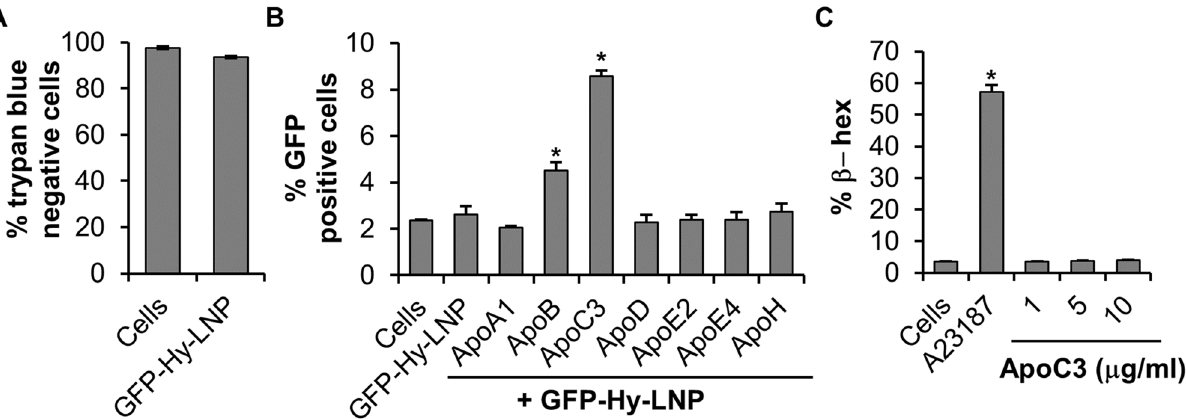
Figure 3. ApoC3 facilitates internalization of GFP-Hybrid-LNP (GFP-Hy-LNP) into BMMC. ( A ) BMMC were treated with GFP-Hy-LNP for 24 h then stained with trypan blue. Cells represent control BMMC that have not been treated with GFP-Hy-LNP. ( B ) BMMC were transfected with 3 µg Apo (ApoA1, B, C3, D, E2, E4 and H)—GFP-Hy-LNP’s or GFP-Hy-LNP alone followed by flow cytometry to determine % GFP positive cells. Cells represent control BMMC that have not been treated with GFP-Hy-LNP or Apo-GFP-Hy-LNP. ( C ) BMMC were treated with 1, 5 or 10 μg/ml ApoC3 for 45 min followed measuring degranulation by calculating the % release of β-hexosaminidase (β-hex). A23187 activated BMMC was include as a positive control. Cells represent control BMMC that have not been treated with A23187 or ApoC3 (n = 4). p < 0.01 (*) is relative to GFP-Hy-LNP ( B ) or cells ( C )